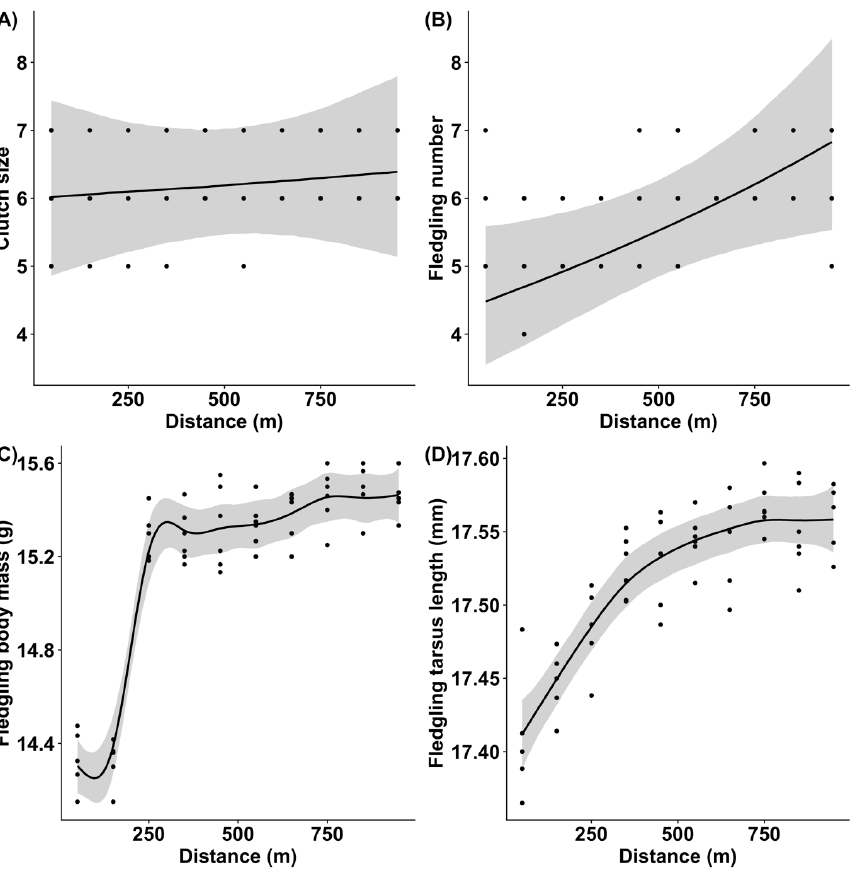
Figure 6. The relationships between the distance to the forest water bodies and clutch size ( A ), fledg- ling number ( B ), fledgling body mass ( C ), and fledgling tarsus length of Pied Flycatchers ( D ). Solid lines show the estimated trendlines by the model, and grey-shaded areas represent 95% credibility intervals.